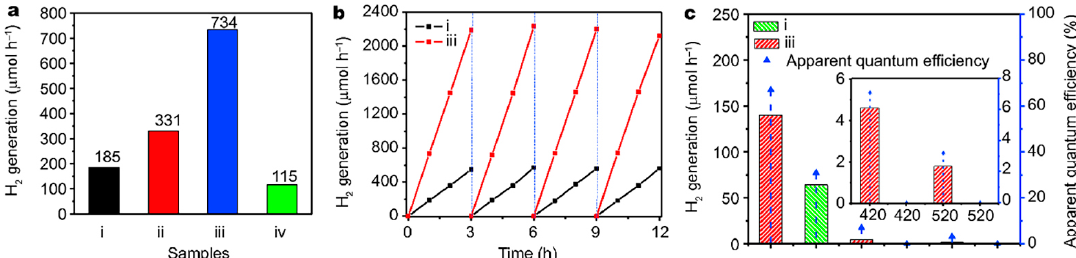
Figure 17. ( a ) Photocatalytic hydrogen evolution rates, ( b ) cycling tests of photocatalytic hydrogen generation under AM 1.5 irradiation, ( c ) the single wavelength photocatalytic hydrogen evolution rates of pristine TiO 2 (i), and hydrogenated TiO 2 at 250 °C (ii), 300 °C (iii), and 350 °C (iv), respectively. Reprinted with permission for ref. [87]. Copyright 2018, Springer.